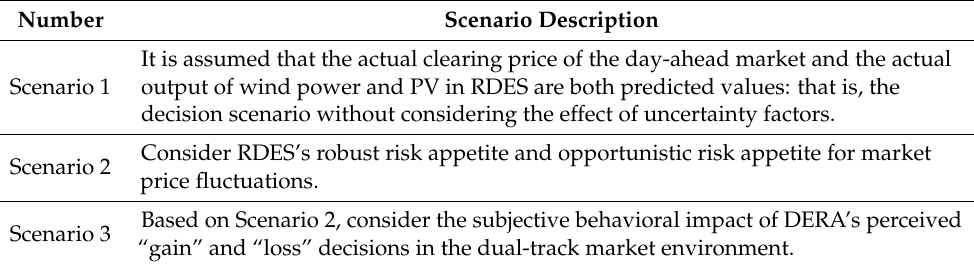
Table 4. Case study scenarios.